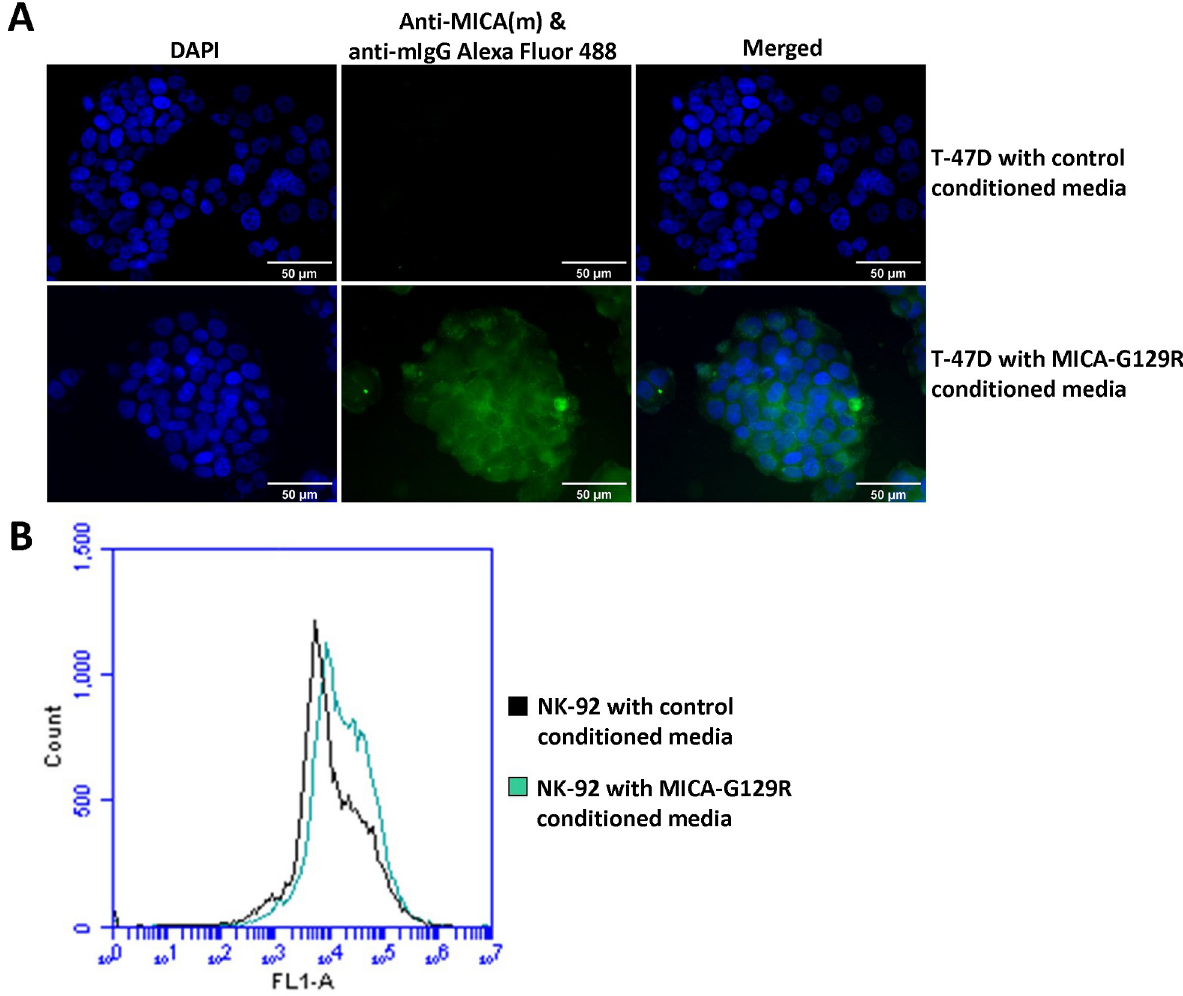
Fig 2. Fusion protein MICA-G129Rbinds to T-47D cells and NK-92 cells. Control or MICA-G129R conditioned media were incubated with ( A ) T-47D cells or ( B ) NK-92 cells for two hours. T-47D cells were fixed and first stained with mouse anti-human MICA primary antibody followed by anti-mouse IgG Alexa Fluor 488 secondary antibody and DAPI, and observed with fluorescence microscope. NK-92 cells without fixation were stained with mouse anti-PRL primary antibody followed by an anti-mouse IgG Alexa Fluor 488 secondary antibody. The stained NK-92 cells were analyzed with flow cytometry. FL1 indicates the 530/30 nm standard interference